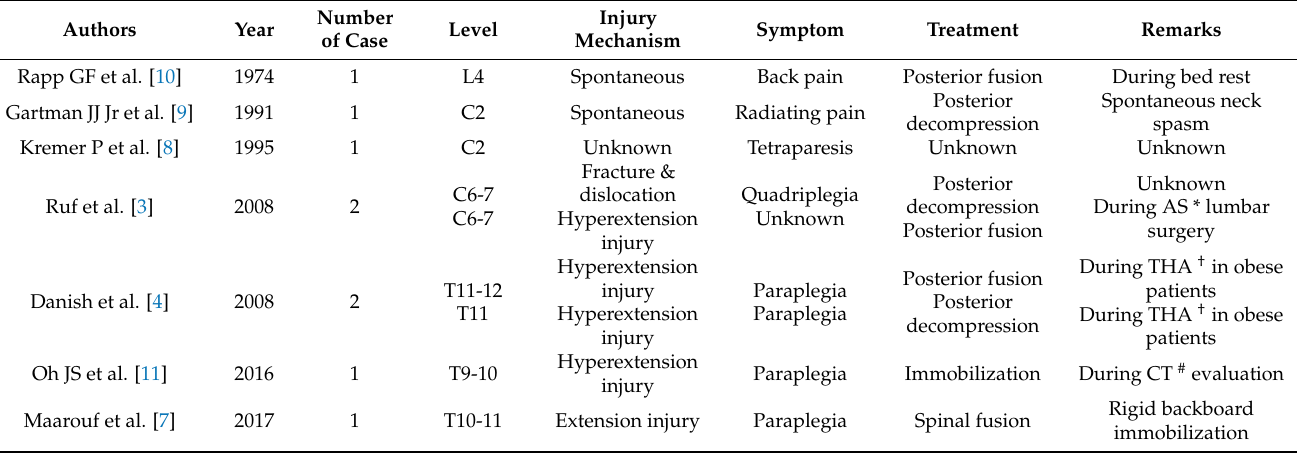
Table 1. Literature review regarding abnormal spine injury in ankylosing